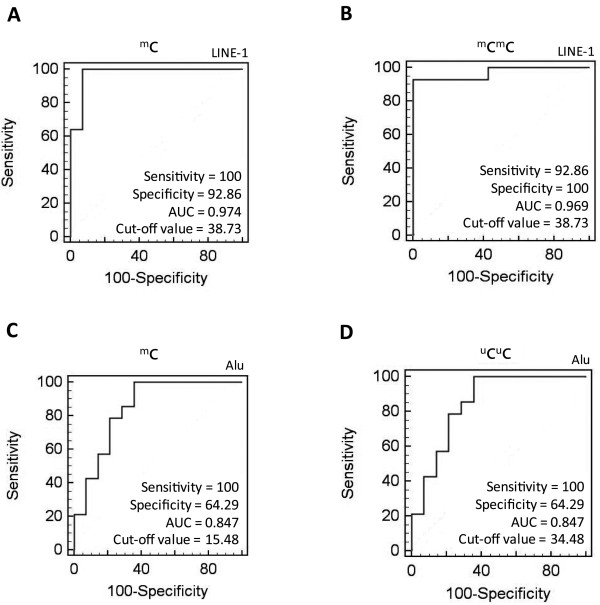
ROC curve analysis of LINE-1 and Alu element methylation for MEC detection. (A) The total LINE-1 methylation level (mC). (B) The mCmC level of LINE-1 methylation. (C) The total Alu element methylation level (mC). (D) The uCuC level of Alu element methylation.